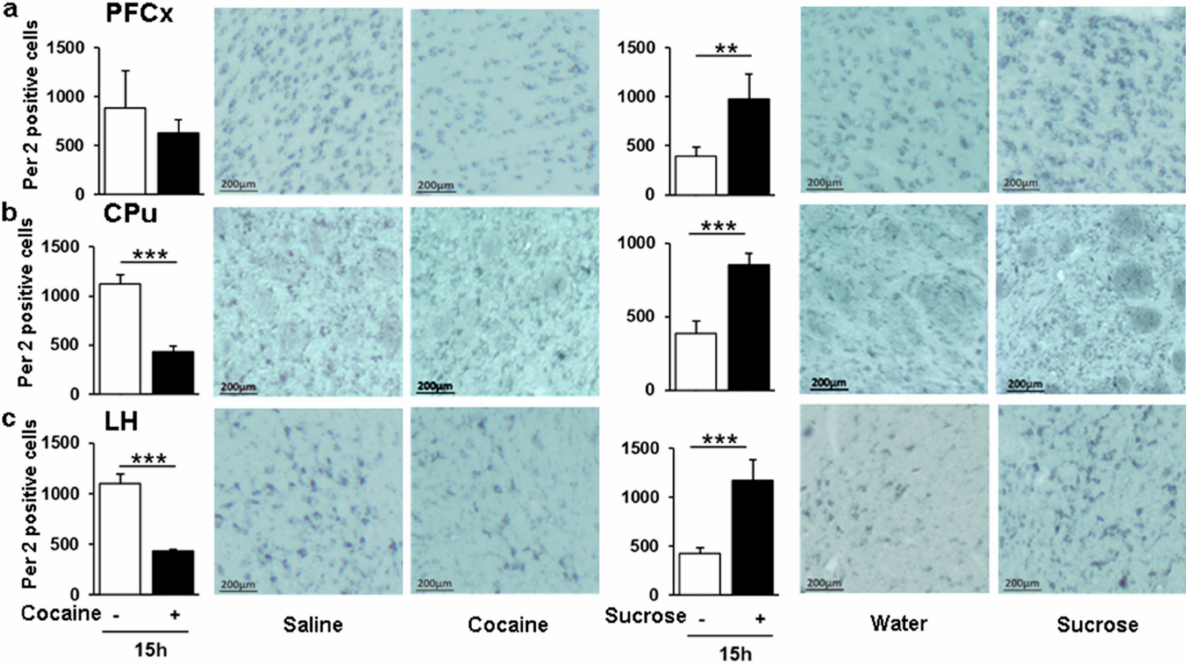
Figure 9. Per2 analysis by IHC in response to passive cocaine and sucrose administration. Quantification and photomicro- graphs showing Per2 immunoreactivity in the PFCx, CPu and LH of rats treated daily for 10 days with saline or 20 mg/kg cocaine (one i.p. injection per day) and with sucrose (one administration per day) ( a – c ). Statistical analysis performed was one-way ANOVA followed by Newman-Keuls post hoc test. Significant differences are indicated with n = 4–5 per group. ** p < 0.01, *** p <